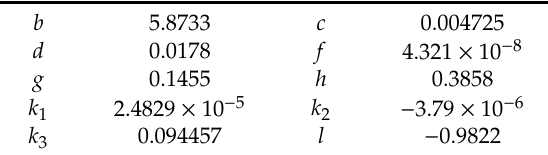
Table 3. Total Loss Constant of the FESU.